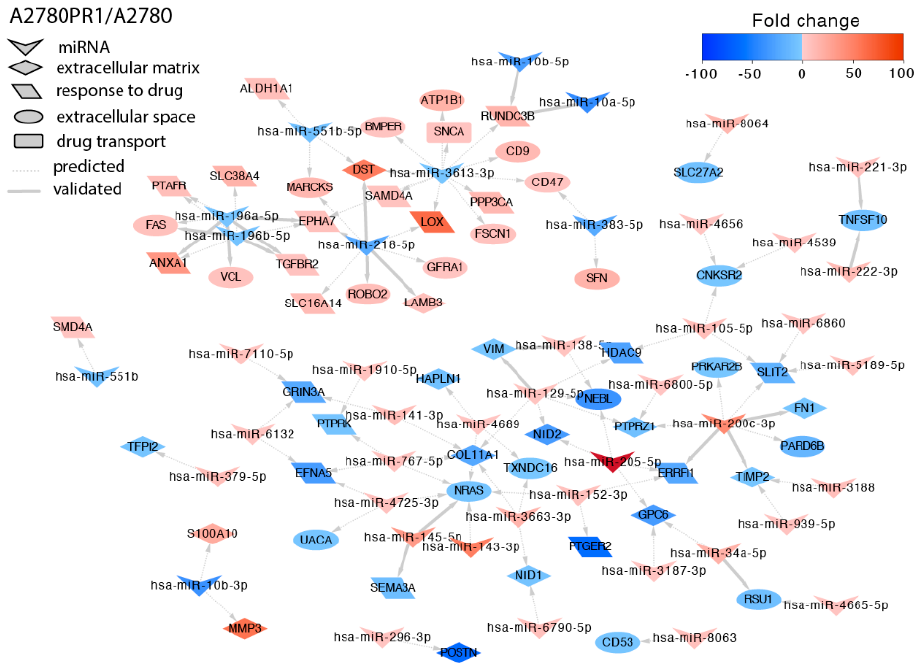
Figure 5. Regulation of selected target genes by miRNAs in the A2780PR1 cell line. In the second PAC-resistant cell line, we identified targets for 13 miRNAs (Figure 6). Increased expression of COL4A1 ( Collagen Type IV Alpha 1 Chain ) resulted from downregu- lation of miR-99a-5p. Similar to in the A2780PR1 cell line, we also observed that